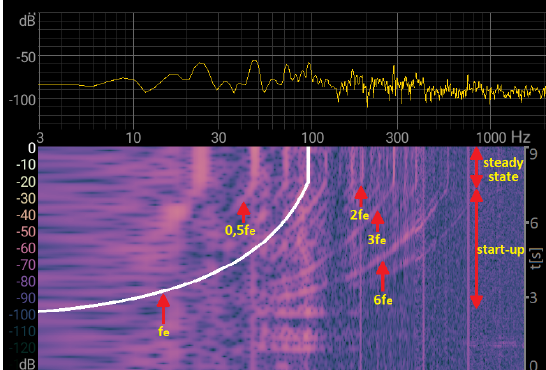
Figure 25. Sound spectrogram measured during start-up ( ω e from 0 to 600 rad (2nd + 6th harmonic) + CHC are applied. Speed ramp 300 rpm